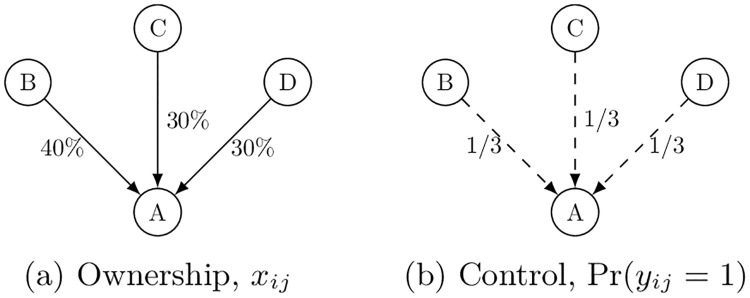
Direct ownership & control.